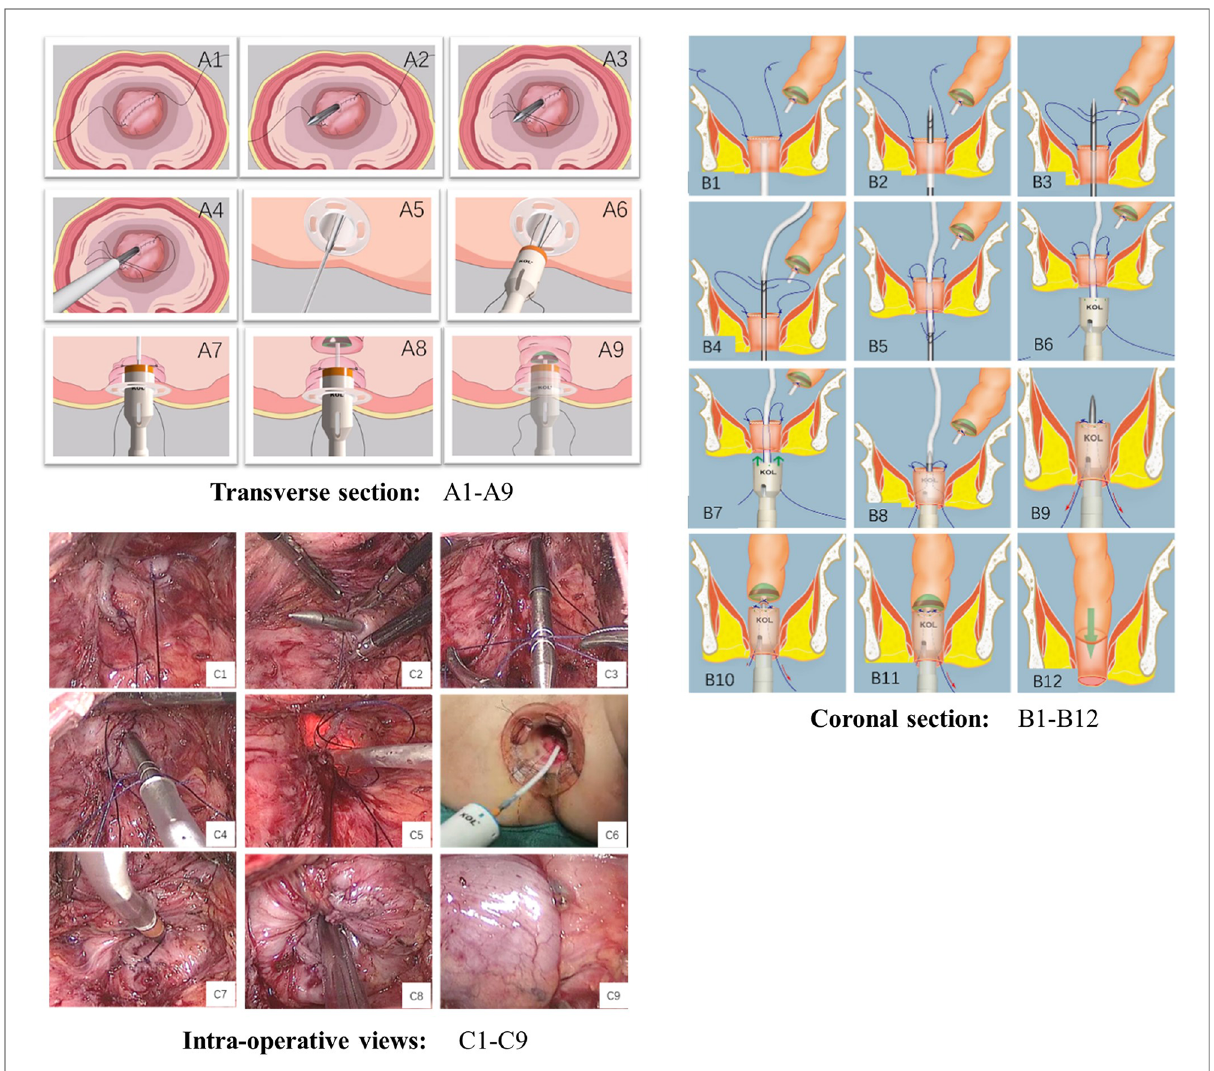
FIGURE 1 Technique of dog-ear invagination anastomosis (transverse section: A1 – A9 , coronal section: B1 – B12 , intra-operative views: C1 – C9